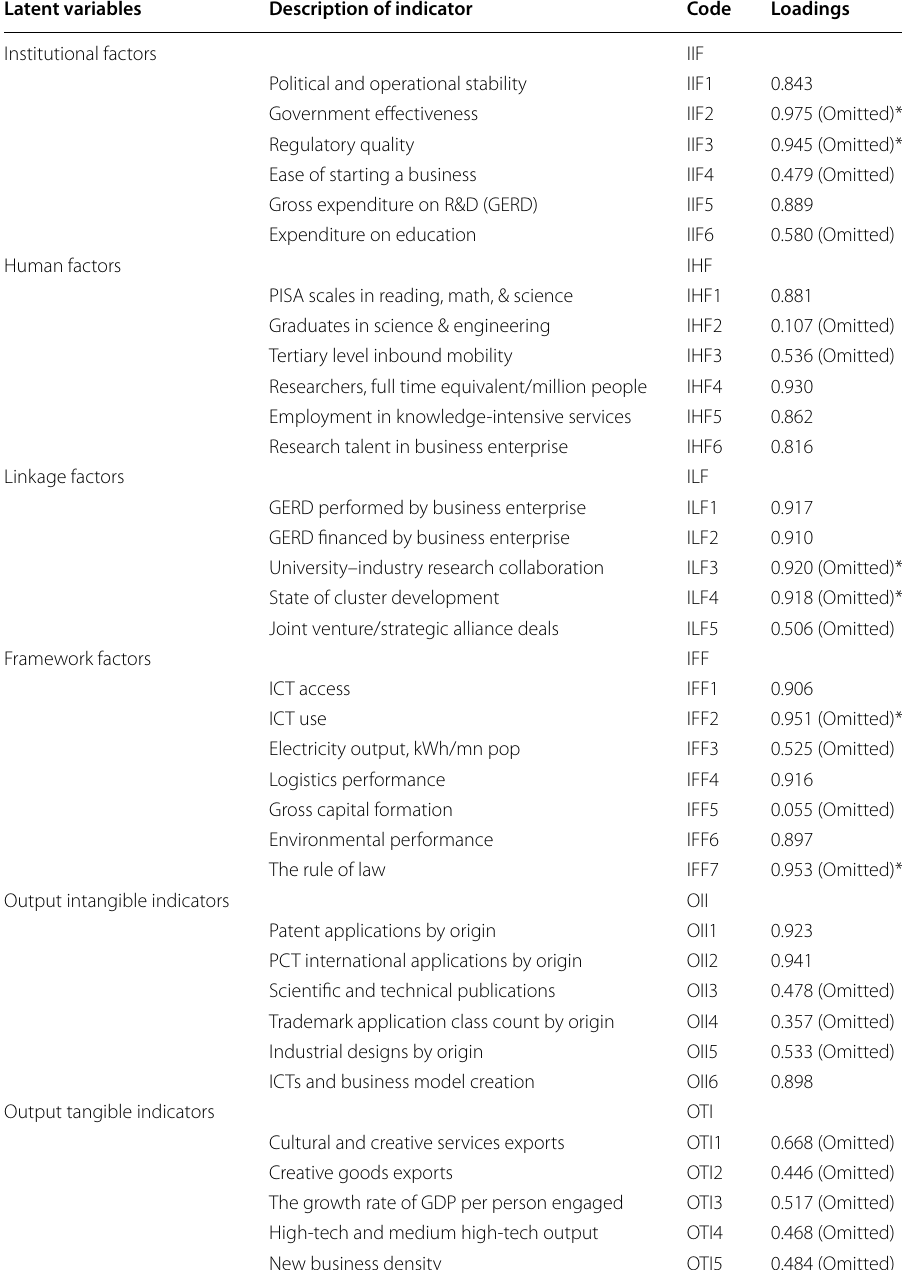
Table 3 Indicators of latent variables qualified for the model Latent